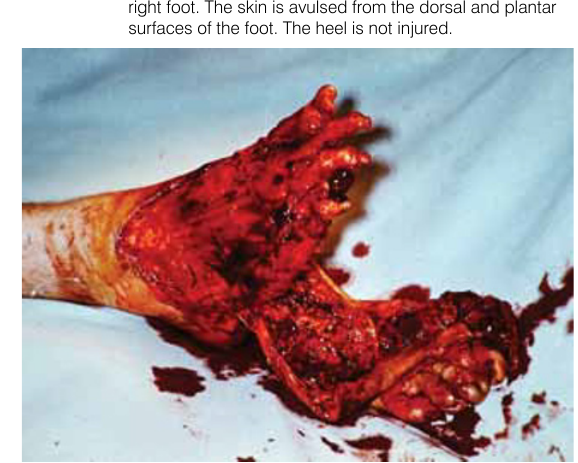
Figure 2. Clinical case 1. The degloved injury of the right hand was wrapped with the free omental fl ap and covered with a spulit-thickness skin graft.